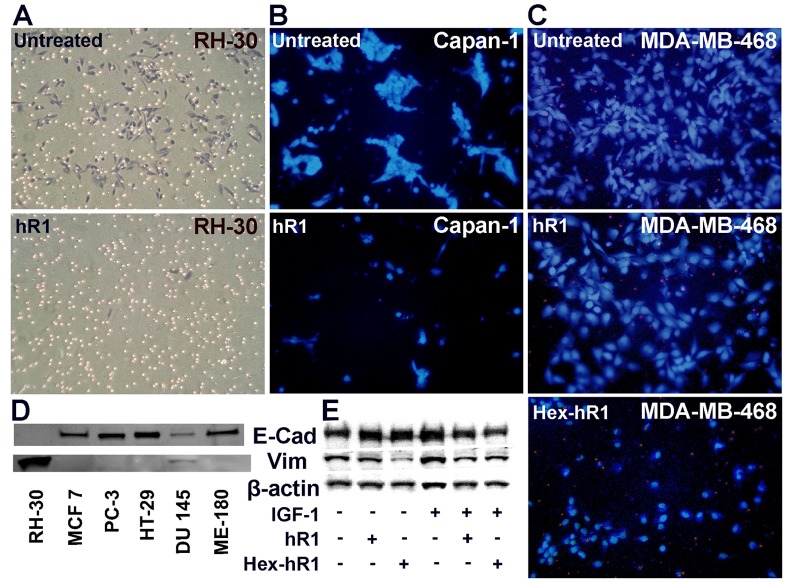
Inhibition of in vitro invasion observed for (A) RH-30 cells treated with 10 µg/mL of hR1;
(B) Capan-1 cells treated with 100 µg/mL of hR1; (C) MDA-MB-468 cells treated 100 µg/mL of hR1or Hex-hR1; (D) expression levels of E-cad and vim in RH-30, MCF7, PC-3, HT-29, DU 145 and ME-180 cells; (E) Western blot analysis of E-cad and vim in DU 145 cells following treatment with hR1 and Hex-hR1 at 100 nM in the absence or presence of IGF-1. Cells were stained with Wright-Giemsa stain (A) or Hoechst 33258 (B and C). β-Actin was used as a loading control in (E).